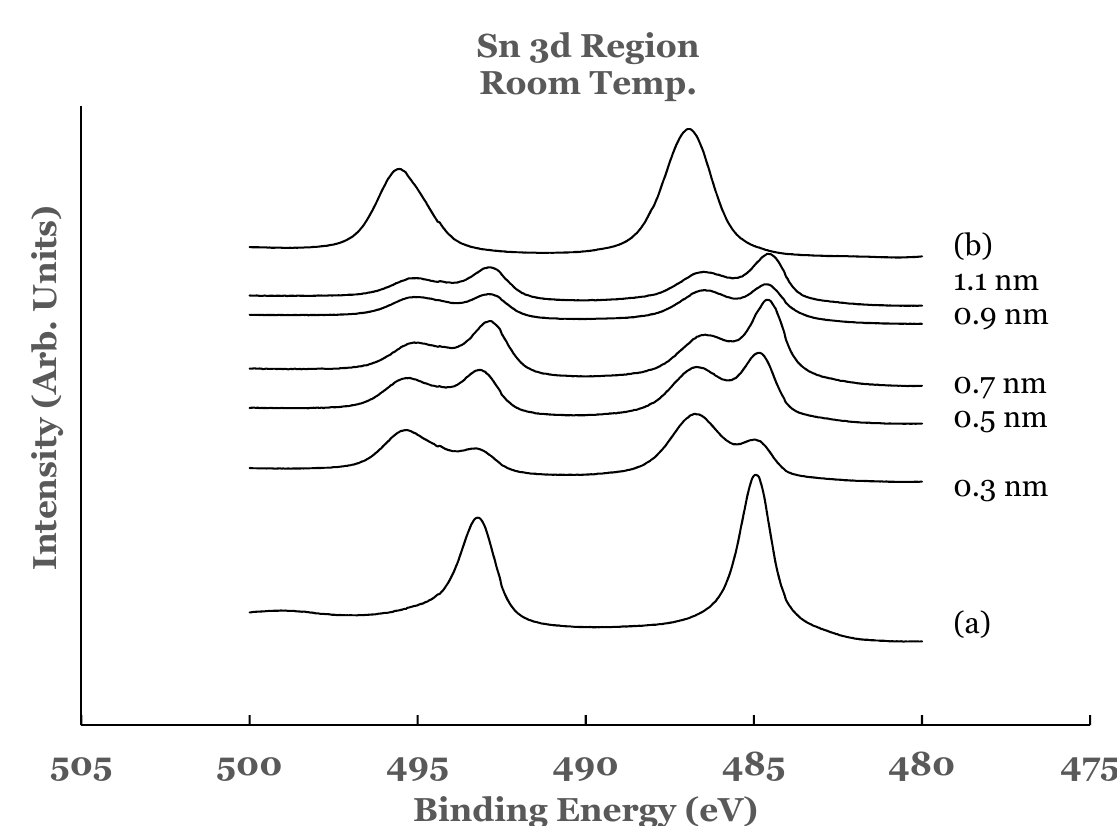
Figure 1. Spectral data in the Sn 3d region as a function of the thickness of the titanium overlayer. The overlayer was deposited at room temperature. Curve (a) corresponds to elemental Sn while curve (b) corresponds to SnO 2 .